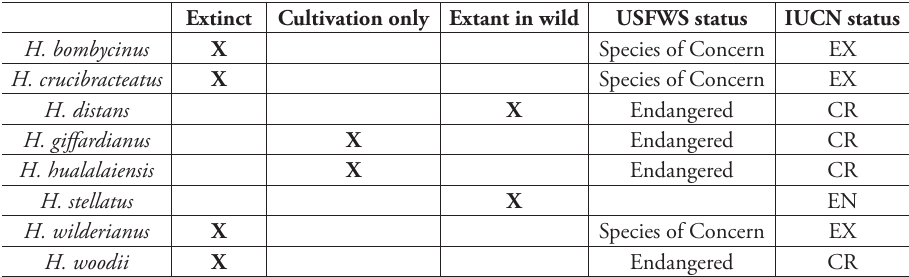
Table 1. Current status of Hibiscadelphus